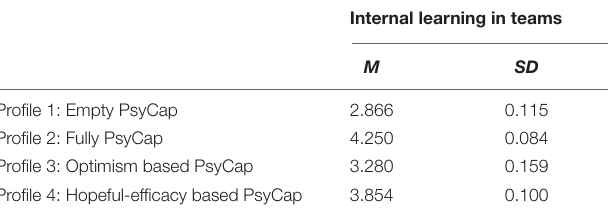
TABLE 4 | Descriptive statistics (means and standard deviations) of internal learning in teams for each PsyCap